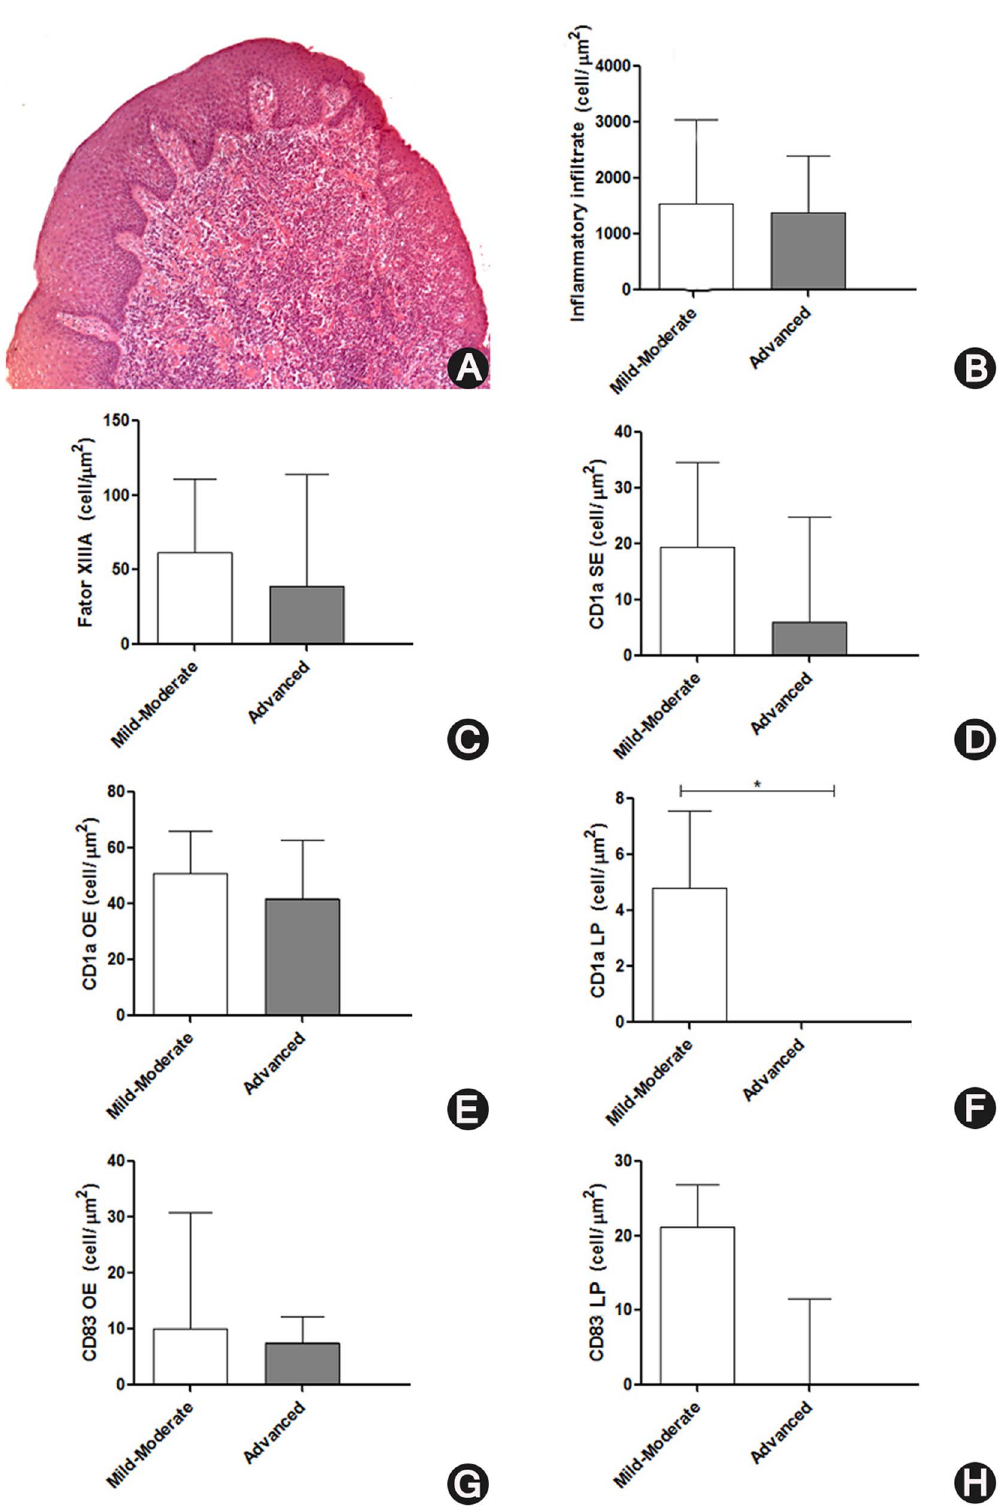
Figure 1. Inflammatory infiltrate cells and dendritic cells (DCs) in individuals with mild-moderate or advanced chronic periodontitis. A) Gingival tissue with intense inflammatory infiltrate on the lamina propria (LP) (haematoxilin-eosin, 50x original magnification). Distribution of the inflammatory infiltrate cells and DCs in groups of individuals with mild-moderate or advanced chronic periodontitis. B) Density of inflammatory infiltrate cells (cells/mm 2 ). C) Density of Factor XIIIa + immature DCs (cells/mm 2 ). Density of CD1a + immature DCs (cells/mm 2 ) in the sulcular epithelium (D), oral epithelium (E), and LP (F). Density of CD83 + mature DCs (cells/mm 2 ) in the oral epithelium (G) and LP (H). *Mann-Whitney U test, statistically significant difference at P , 0.05.